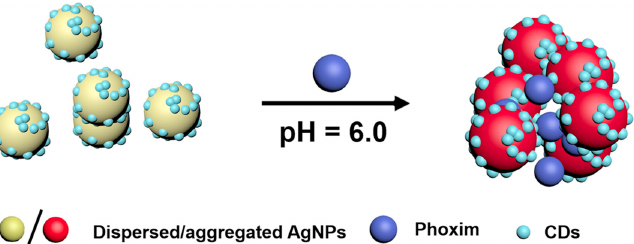
Figure 5. Scheme of the detection mechanism of Phoxim by CDs-modified AgNPs. Reprinted with permission from [90], copyright 2018 Elsevier B.V. permission from [90], copyright 2018 Elsevier